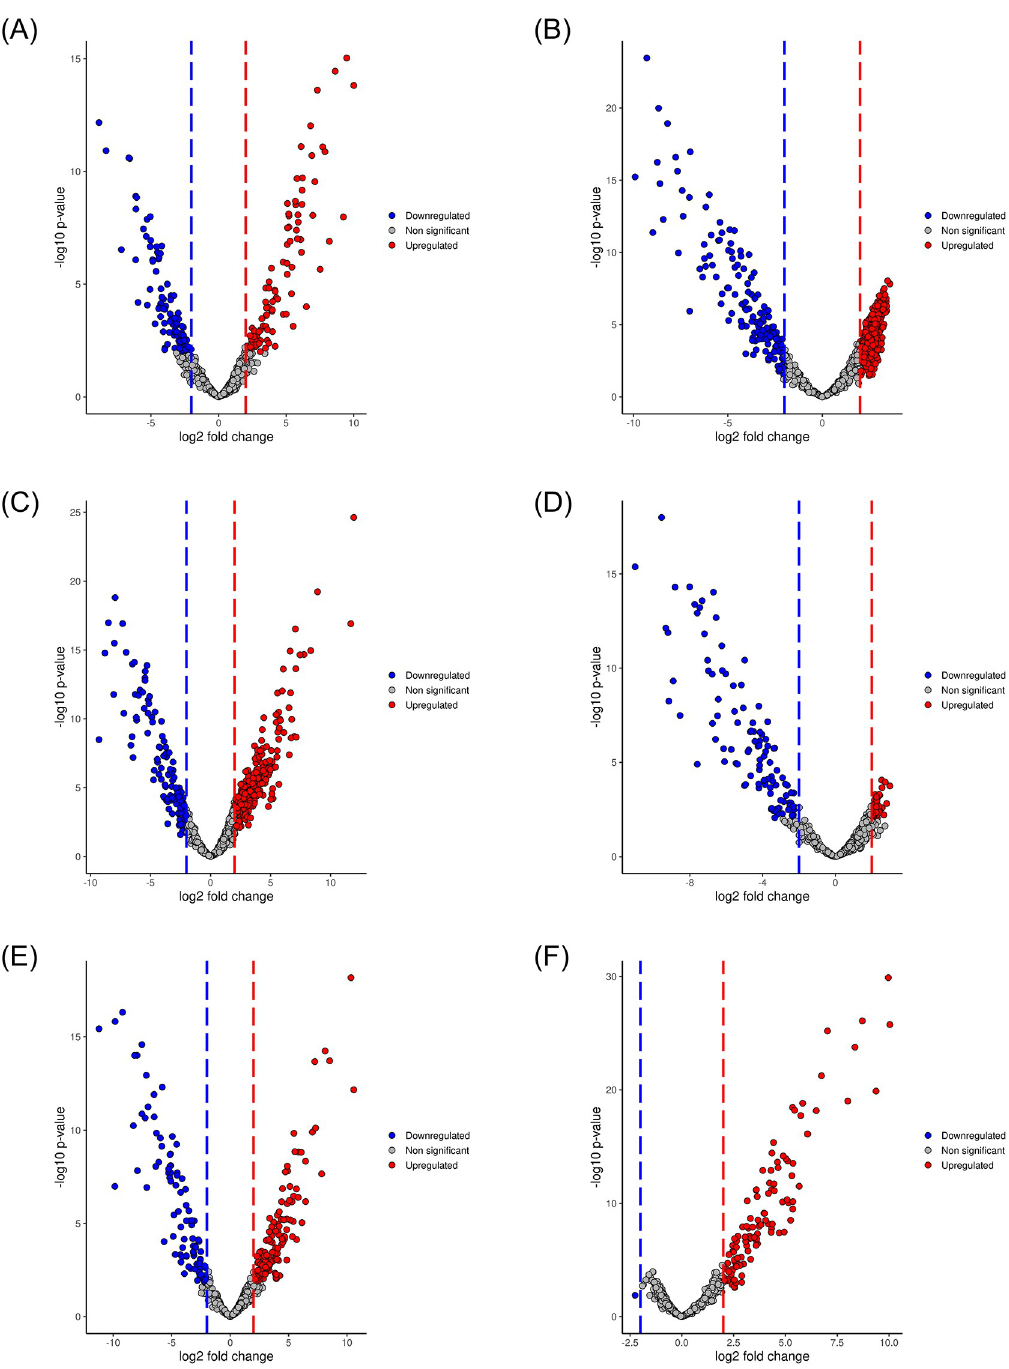
Fig 4. Volcano plots showing regulated proteins in different body sites post-SARS-COV-2 infections in the human host. (A) shows regulated proteins in BALF vs. gargle solution, (B) BALF vs. nasopharynx, (C) BALF vs. urine, (D) gargle solution vs. nasopharynx, (E) gargle solution vs. urine, and (F) nasopharynx vs. urine. The “red” and “blue” dots represent upregulated and downregulated proteins respectively. The “grey” dots represent non-significant proteins.